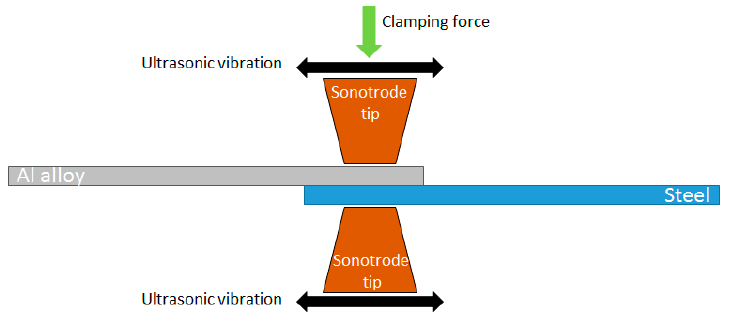
Figure 15. Ultrasonic spot welding.